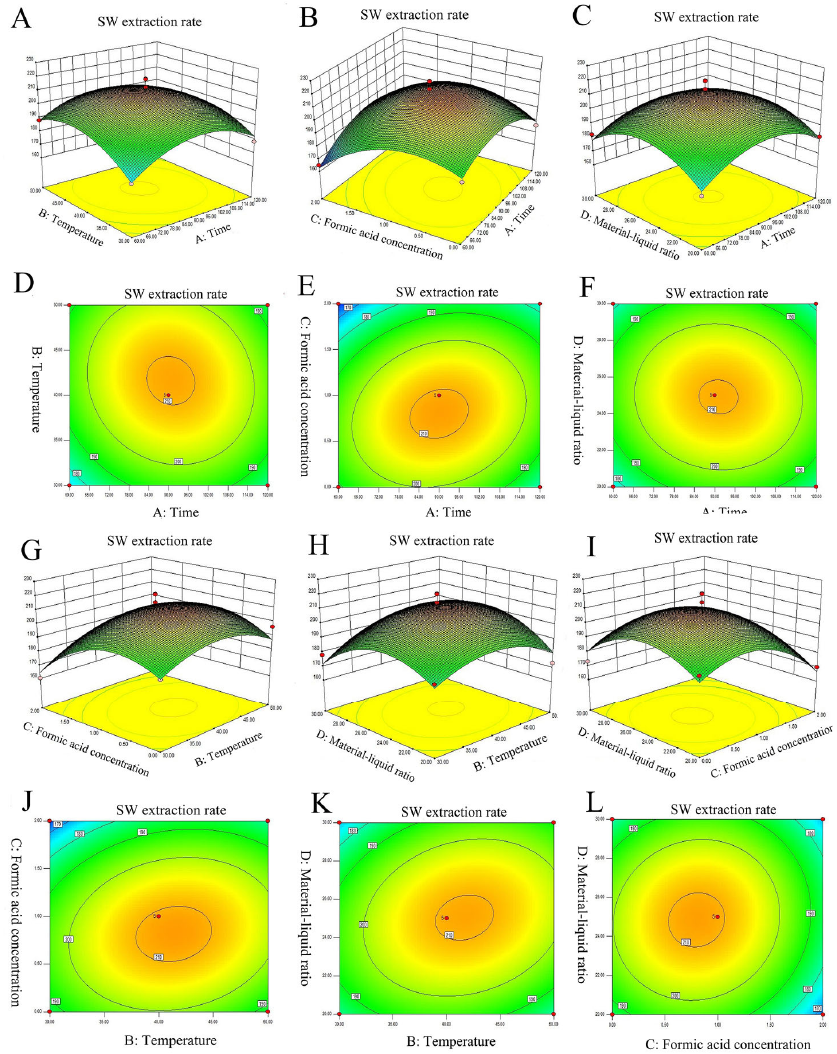
Figure 3. Response surface and contour diagram of interaction of different factors on SW extraction rate. ( A , D ) Response surface and the contour plot of the interaction of extraction time and ultrasonic temperature to SW extraction rate. ( B , E ) Response surface and the contour plot of the interaction of extraction time and formic acid concentration to SW extraction rate. ( C , F ) Response surface and the contour plot of the interaction of extraction time and material-solvent ratio to SW extraction rate. ( G , J ) Response surface and the contour plot of the interaction of ultrasonic temperature and formic acid concentration to SW extraction rate. ( H , K ) Response surface and the contour plot of the interaction of ultrasonic temperature and material-solvent ratio to SW extraction rate. ( I , L ) Response surface and the contour plot of the interaction of formic acid concentration and material-solvent ratio to SW extraction